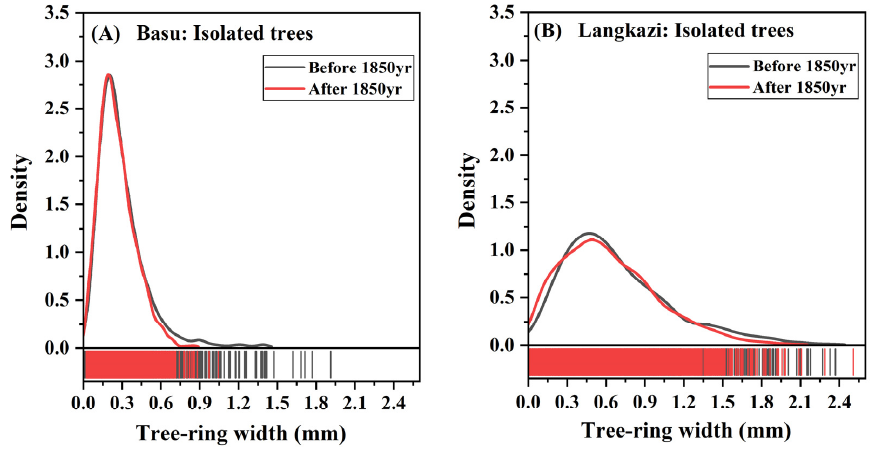
Figure 3. Distribution curve of kernel probability density of the ring-width data from the isolated trees before and after the year 1850 for the Basu treeline ( A ) and the Langkazi treeline ( B ) in Tibet. Coefficients of variation of the ring-width sequences were different for the isolated trees and non-isolated trees during their common growth period, that is, 1942–2010 for the Basu treeline and 1900–2002 for the Langkazi treeline (Figure 4). The coefficients of variation in ring-width data of the isolated trees were greater than those of the non-isolated trees in both treelines.